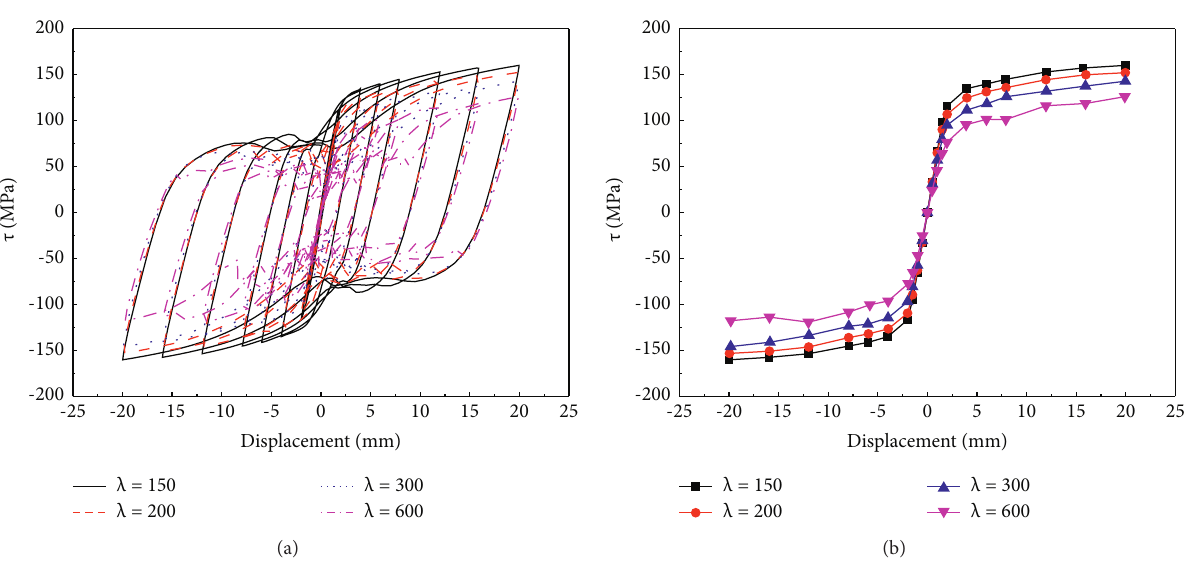
Figure 22: The effect of slenderness ratio. (a) Hysteretic curves. (b) Skeleton